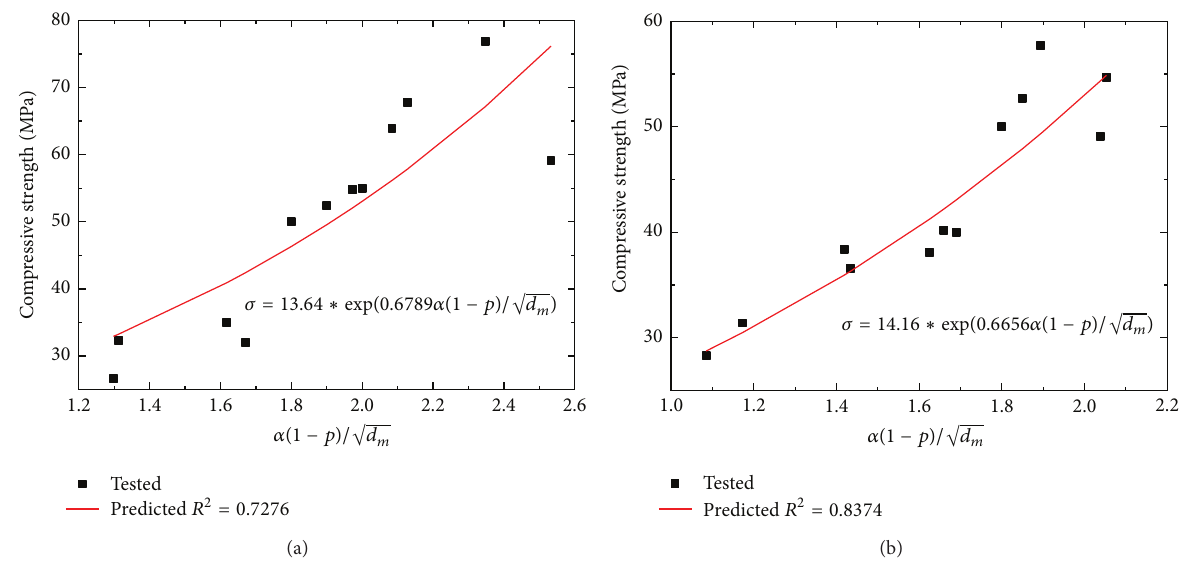
Figure 9: Relationship between experimental results of compressive strength and model formula 𝛼(1 − 𝑝)/√𝑑 𝑚 : (a) manufactured sand mortar and (b) natural sand